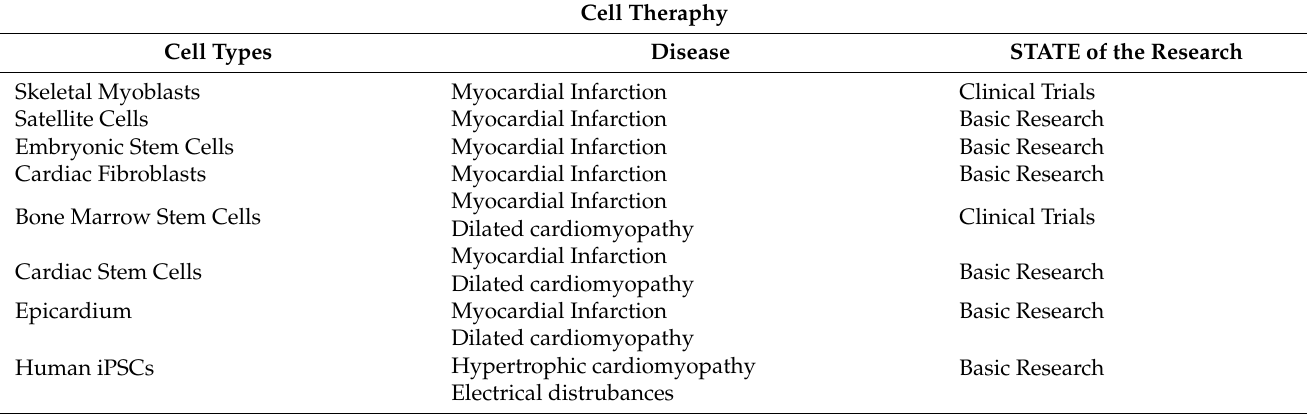
Table 1. List of the different cellular and molecular therapeutic options provided to date to treat the damaged